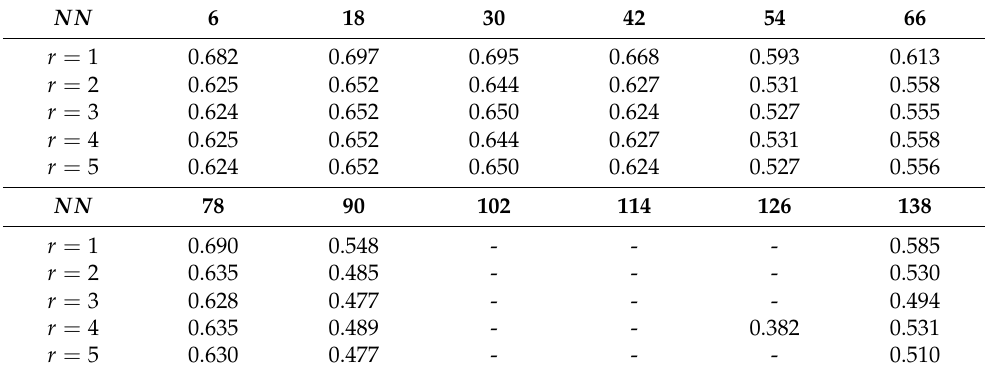
( ) NN . “-“ represents all the